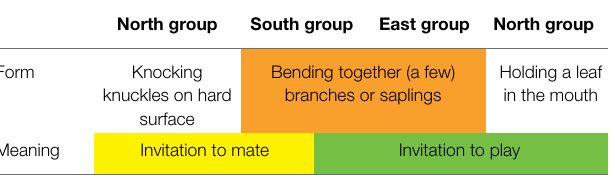
TABLE 2 | Arbitrary relation between form and meaning in Taï group-specific gestures.